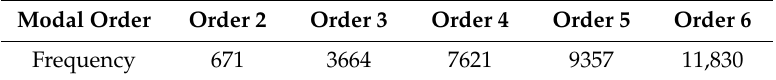
Figure 19. Finite element simulation model of the stator core. ( a ) Second order model. ( b ) Third order model. ( c ) Fourth order model. ( d ) Fifth order model. ( e ) Sixth order model. Table 2. Modal frequency of stator core (Hz).